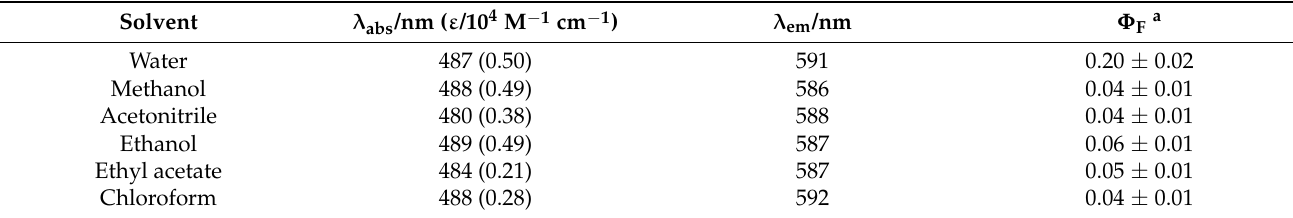
Table 2. Maximum absorption ( λ abs ) and emission wavelengths ( λ em ), molar absorption coefficients ( ε ) and fluorescence quantum yields ( Ф F ) for doxorubicin in several solvents.